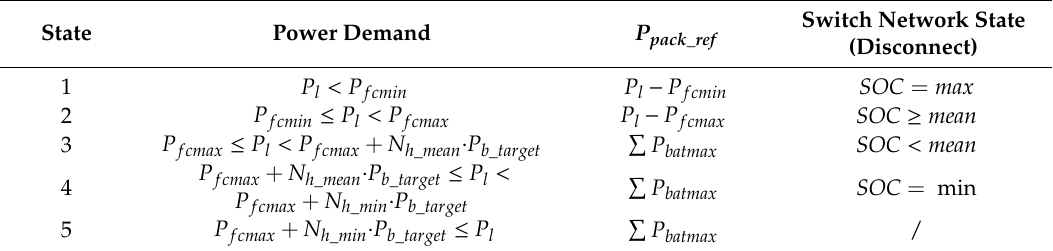
Table 4. Rules of equalization energy management strategy (EEMS) ( N high ≥ N low